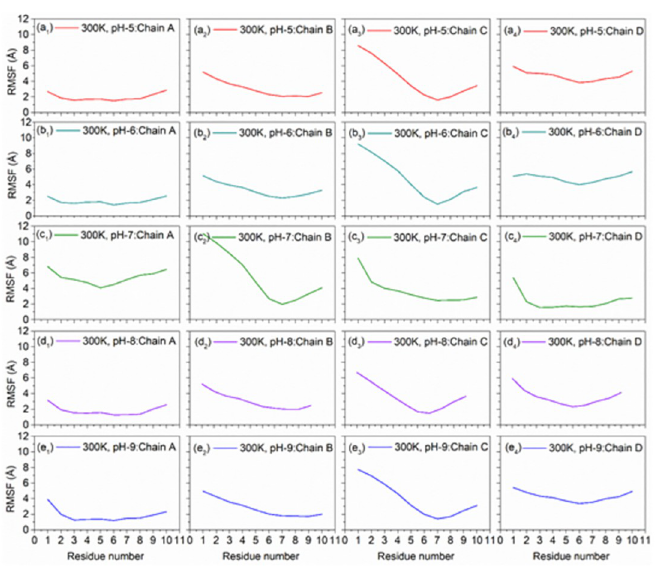
Fig 9. RMSF plots of the MD simulated DNA Junctions at 300K with altered pH, viz. (a 1 -a 4 ) pH5, (b 1 -b 4 ) pH6, (c 1 - c